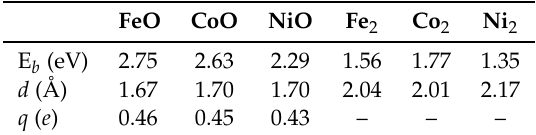
Table 1. Binding energies (E b ) in eV, bond distance ( d ) in Å and electronic charge transfer ( q ) in e units, of the TMO oxides (TM = Fe, Co, Ni) and TM dimers. FeO CoO NiO Fe 2 Co 2 Ni 2 E b (eV)